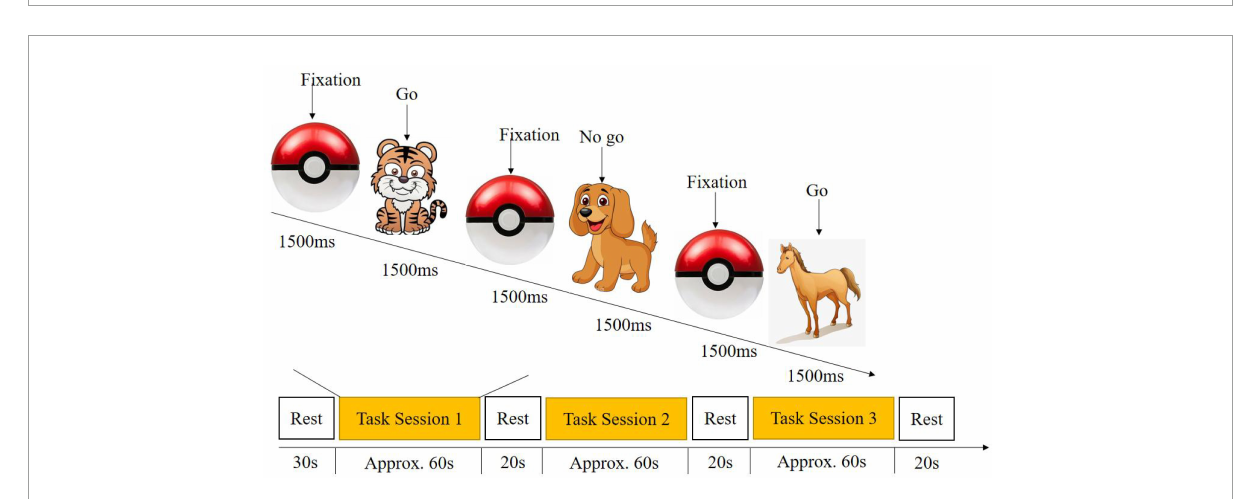
FIGURE2 Experiment paradigm of the go/no-go task.